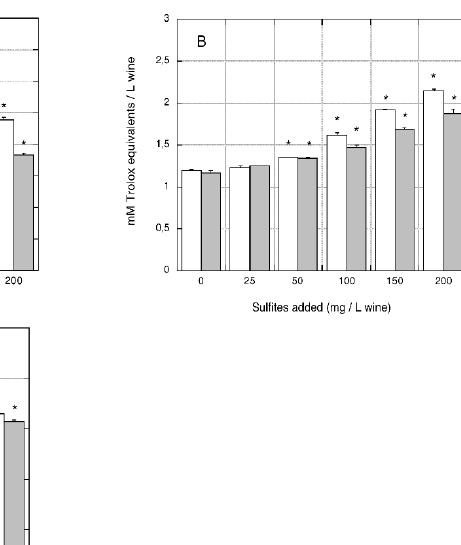
Figure 6. Effect of sulfite/metabisulfite addition to organic white wines on the antioxidant activity measured with the ABTS assay. The ABTS assay was performed using trolox for the calibration curve. ( A ): AO organic wine; ( B ) BO organic wine; ( C ) CO organic wine. Closed grey bars: sodium sulfite addition. Open white bars: sodium metabisulfite addition. Data are means of four replicates ± SE. * p < 0.05 relative to control, without sulfite/metabisulfite addition, by Student t -test.